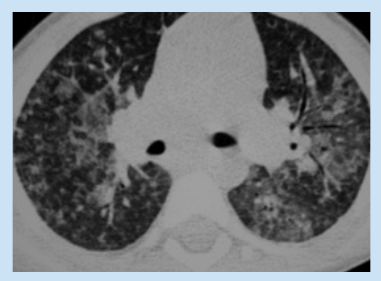
Fig. 22b. Idiopathic pulmonary haemosiderosis.